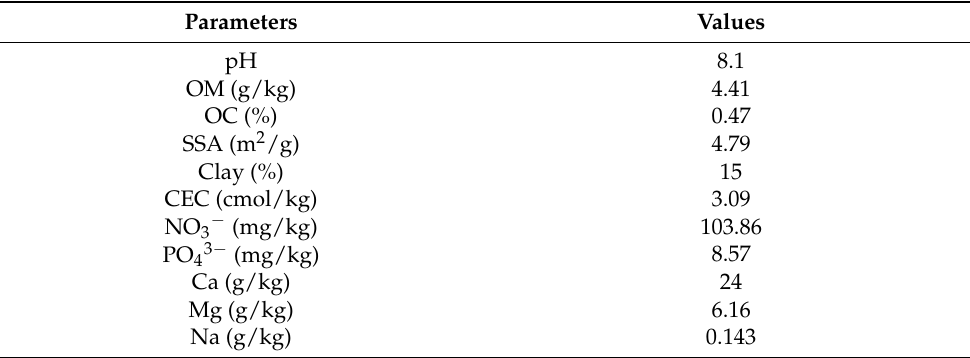
Table 1. The physicochemical properties of the